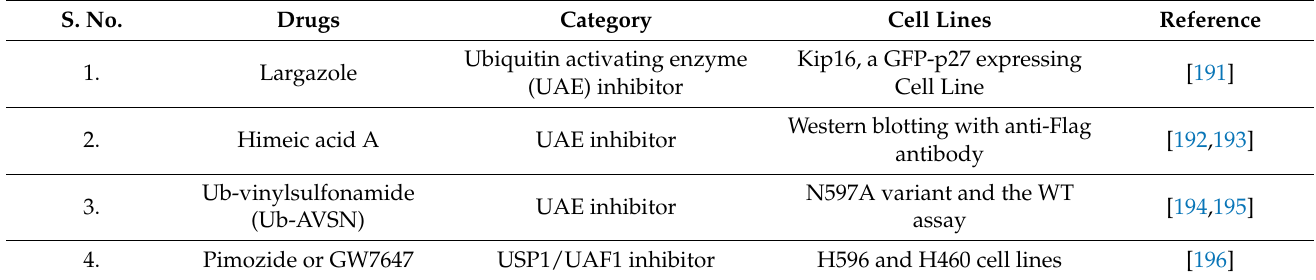
Table 3. In vitro studies of the ubiquitin inhibitors supporting the suppression of